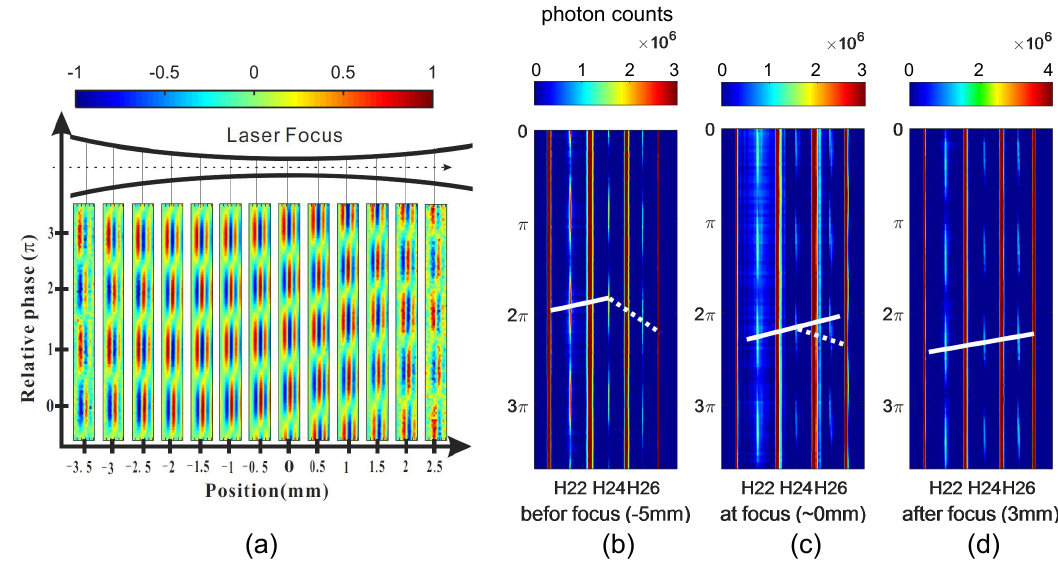
Figure 5. ( a ) Normalized THz waveform as a function of the dual-color relative phase and the position of gas jet. ( b – d ) The harmonic yields (with the background signals removed) as functions of the dual-color relative phase and the position of gas jet relevant to the laser focus. For a clear visualization of the intensity modulations of the even harmonics, the intensity at and beyond 3 × 10 6 photon counts is represented by the same color scale. The solid (dashed) white lines indicate the short (long) trajectory